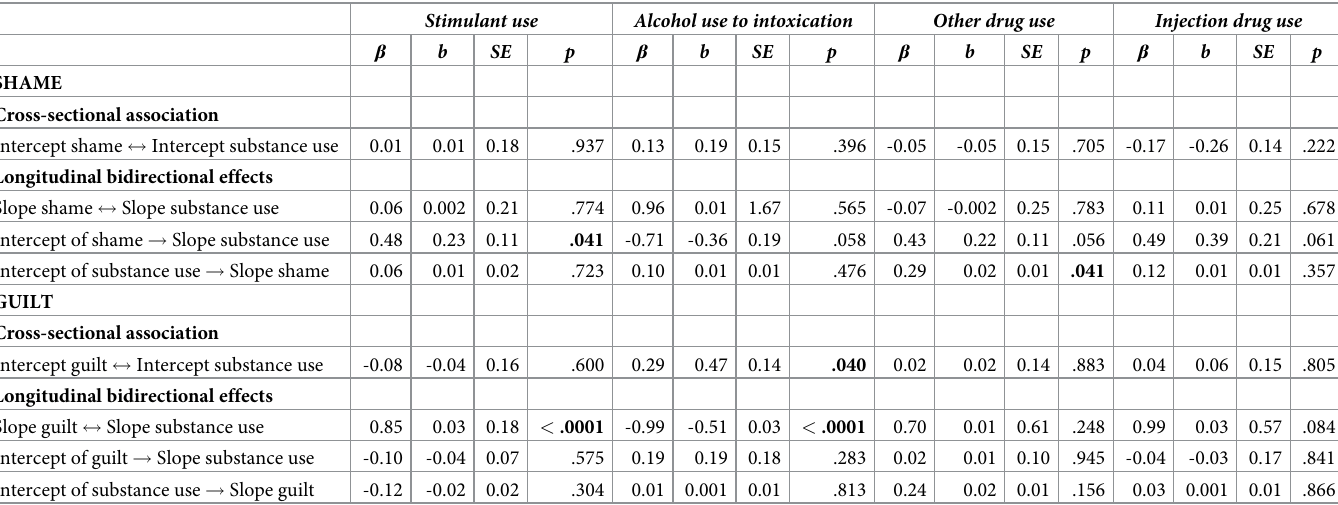
Table 4. Parallel process latent growth curve models, N =